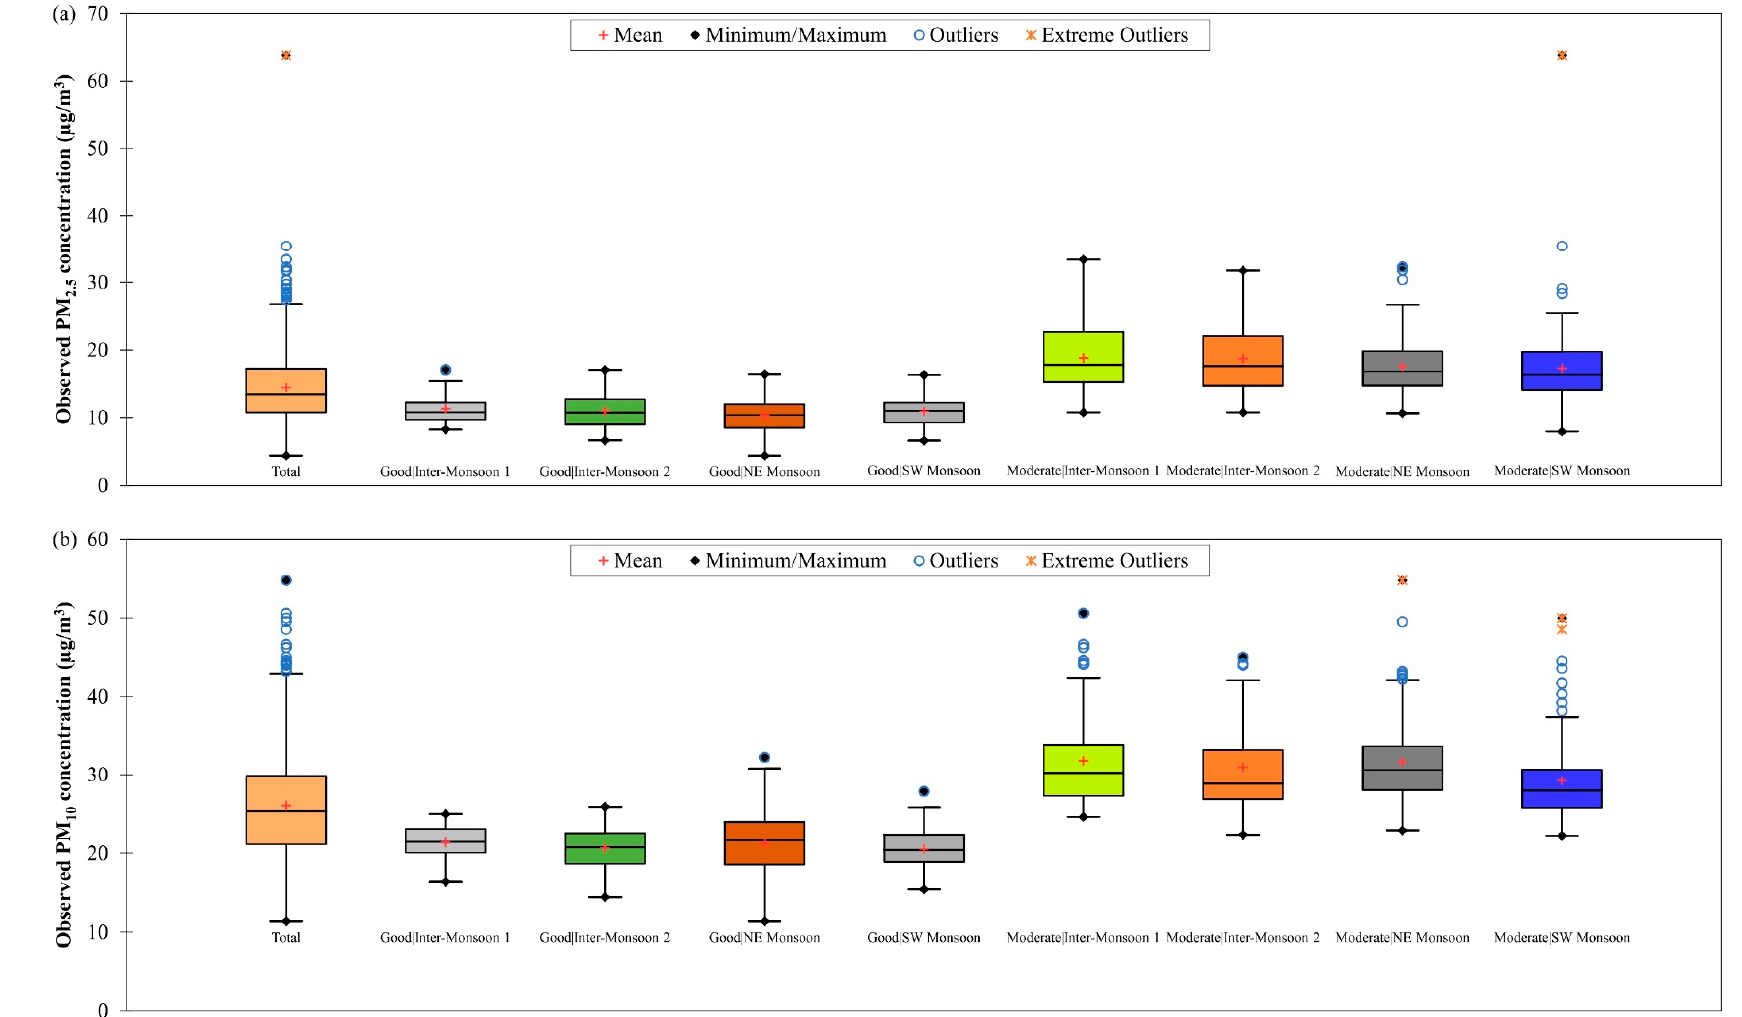
Figure 3. Box plots of observed daily ( a ) PM 2.5 and ( b ) PM 10 concentrations in Singapore from March 2016 to February 2018 during good and moderate air quality conditions in different monsoon seasons.